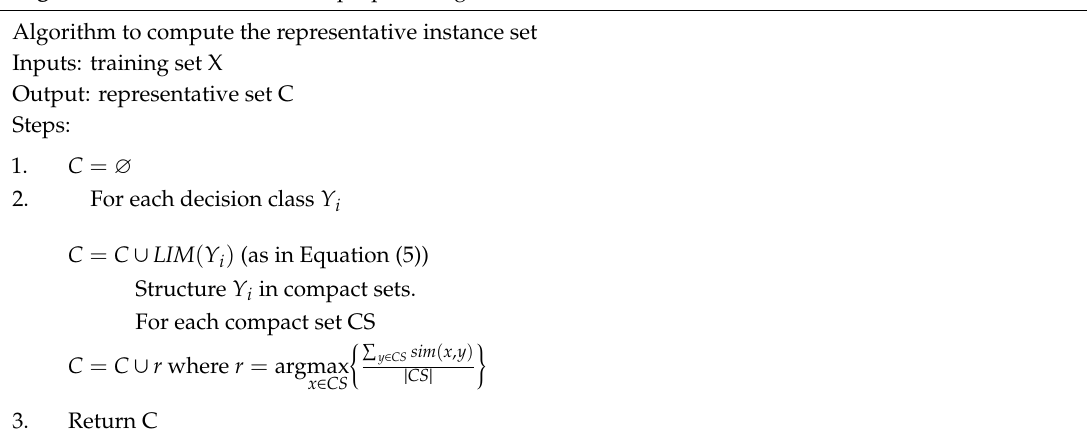
Algorithm 1. Pseudocode of the proposed algorithm. Algorithm to compute the representative instance